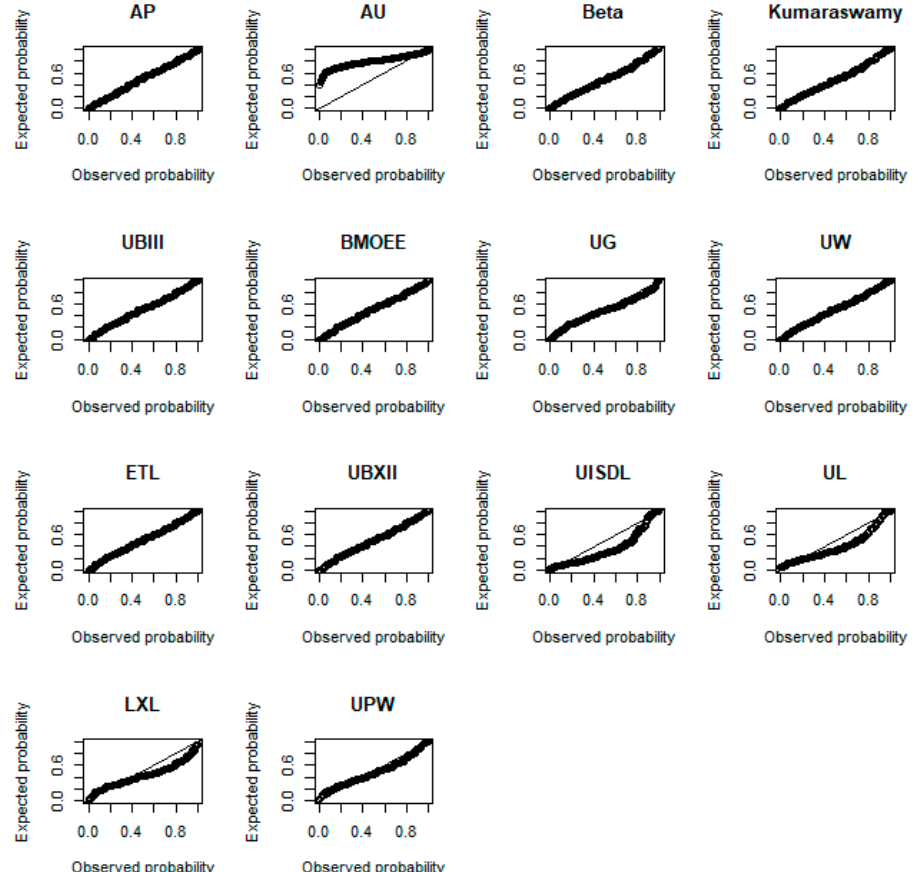
Figure 9. P-P plots of the fitted distributions.